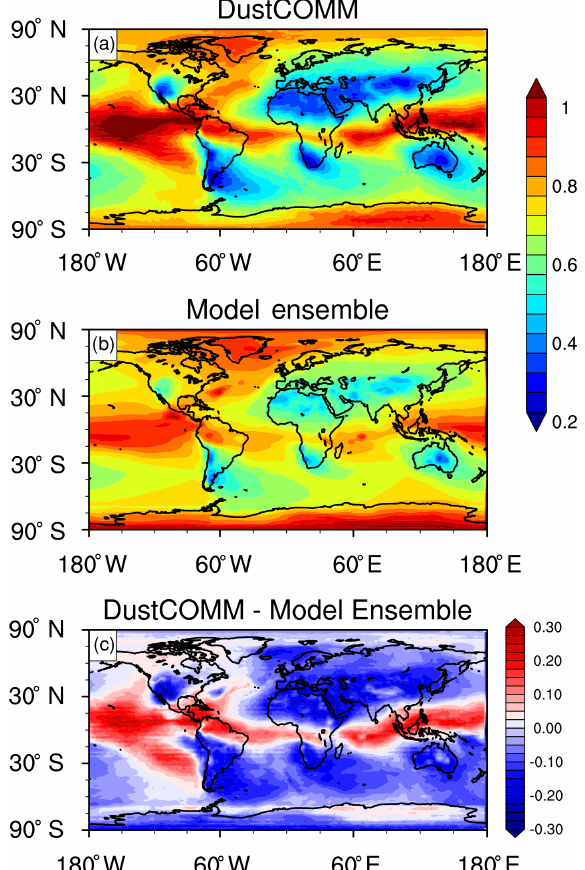
Figure 9. Spatial distributions of column-integrated dust MEE (m 2 g − 1 ), weighted by the dust vertical distribution, for (a) Dust- COMM, (b) the model ensemble, and (c) the difference between the two (DustCOMM − model